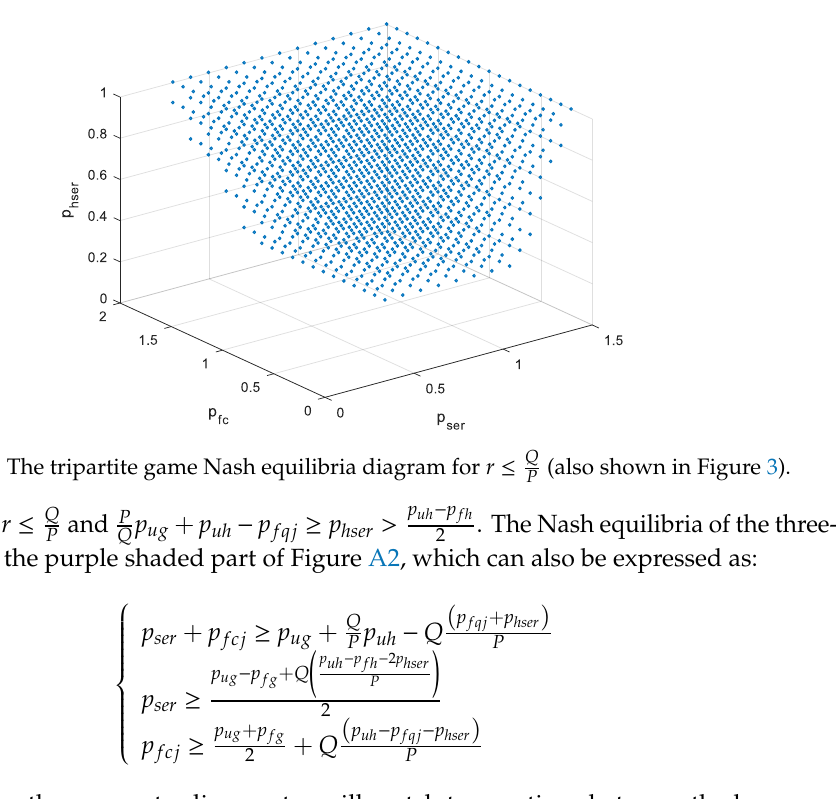
max ser p Figure A2. Scenarios 1,2: two-dimensional sketch of the tripartite game Nash equilibria. When 𝑟 > 𝑄 𝑃 , the Nash equilibria of the tripartite game are shown in Figure A3. c) Scenario 3: 𝑟 > 𝑄 𝑃 and 𝑝 ℎ𝑠𝑒𝑟 ≤ 𝑝 𝑢ℎ −𝑝 𝑓ℎ 2 . The Nash equilibria of the three-party game are shown in the black shaded part of Figure A4, which can also be expressed as in Eq. (A-3).